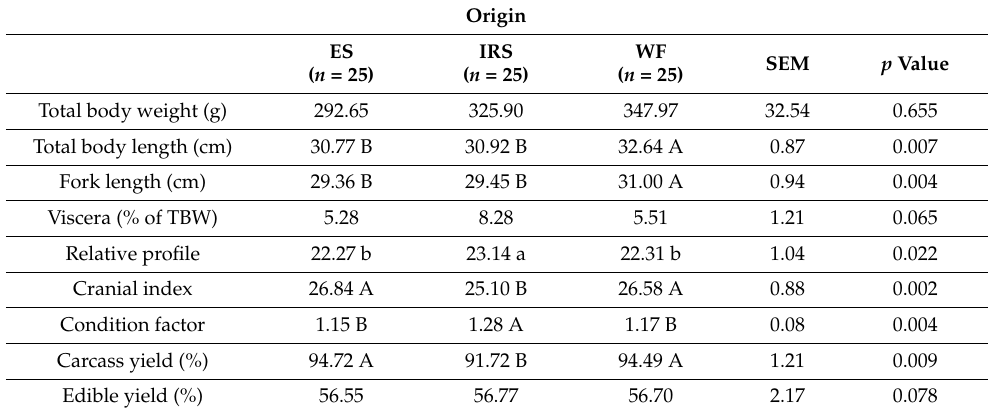
Table 2. Morphometric and biometric indices for each rearing system of sea bass.